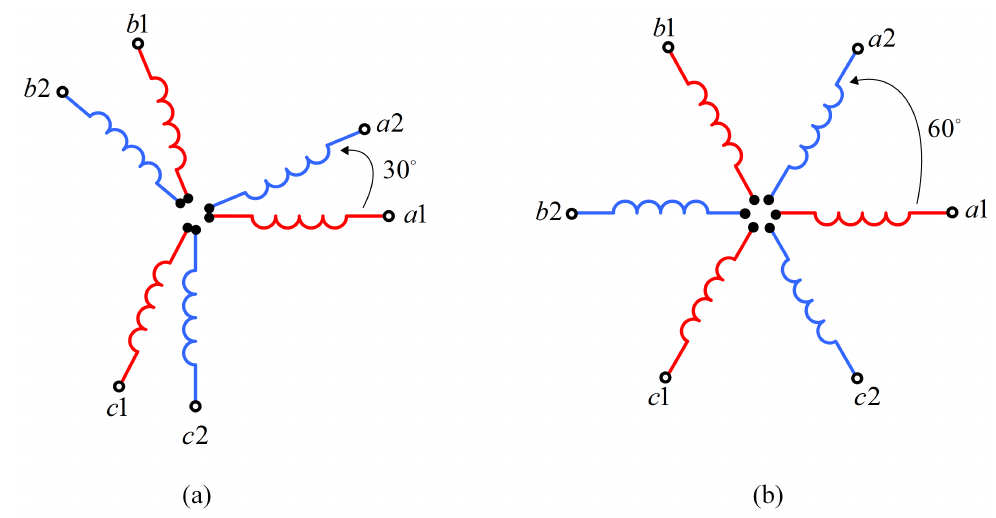
Figure 1. Arrangement of winding in DTP-Machine: ( a ) asymmetrical; ( b ) symmetrical.